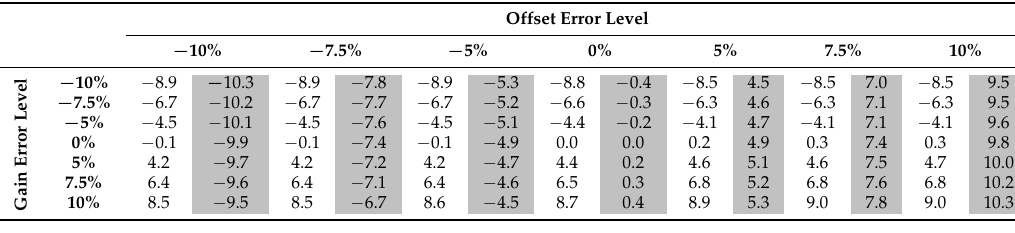
Table 5. Combined error detection in real